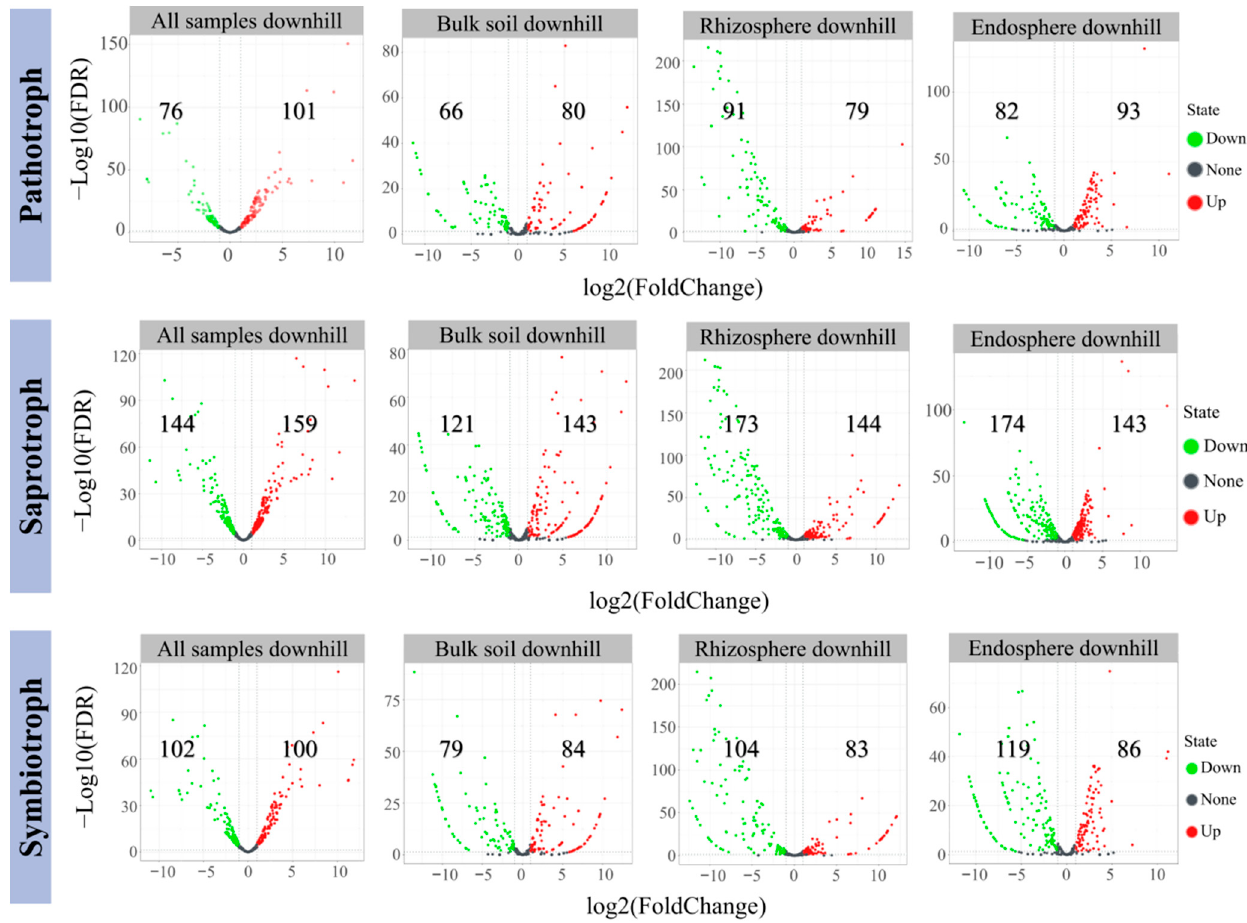
Figure 7. The enriched and depleted functional fungal OTUs in all downhill samples, downhill bulk soil, downhill rhizosphere, and downhill root endosphere. The enriched and depleted pathotroph, saprotroph, and symbiotroph are shown; all uphill samples, uphill bulk soil, uphill rhizosphere, and within uphill root endosphere were used as controls.